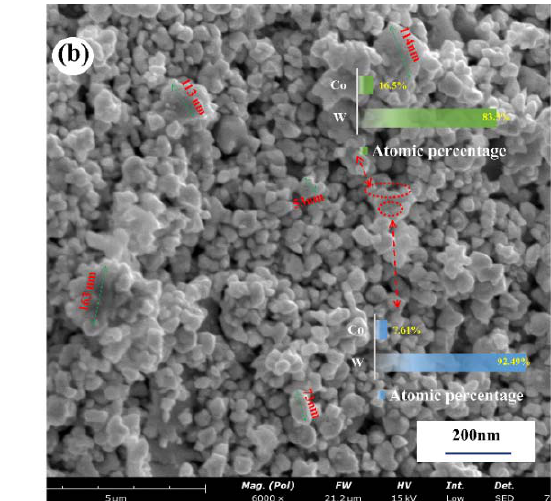
Figure 4. ( a ) Microscopic morphology of mixed powder particles, ( b ) morphology of mixed powder particle distribution .